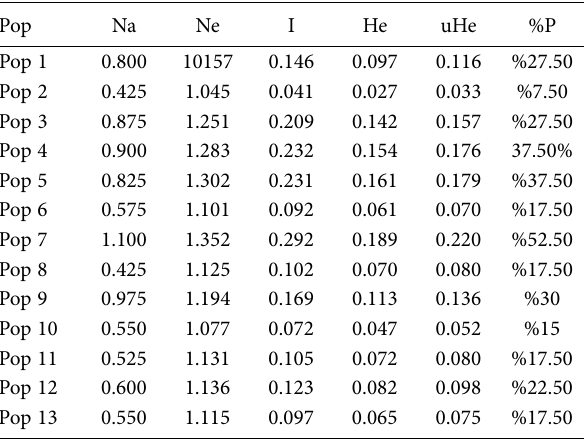
Table 5. Genetic variability parameters determined in Ziziphus jujube populations based on ISSR markers (pop ulations numbers are according to Table 1).